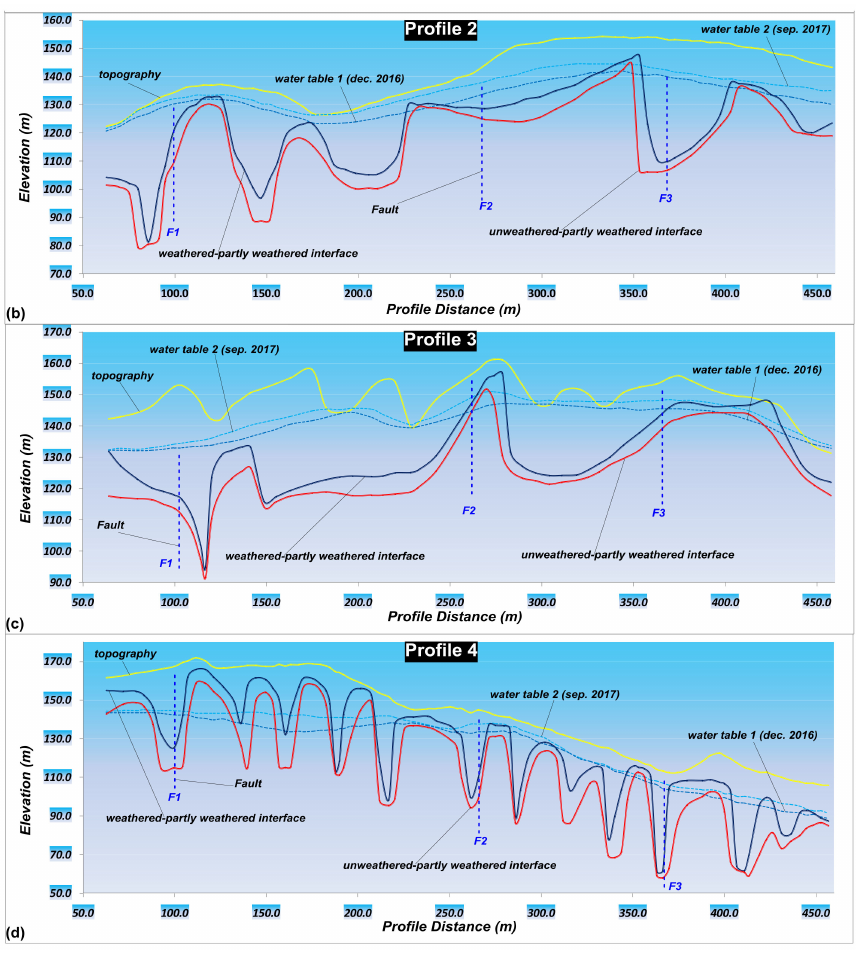
Figure 16. Graphical representation of weathered-partly weathered, unweathered-partly weathered, water table and topography curves along ( a ) profile 1, ( b ) profile 2, ( c ) profile 3 and ( d ) profile 4.